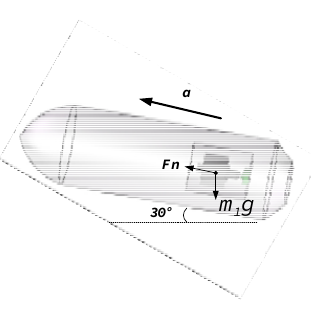
Figure 15. Acceleration of the system spindle direction.